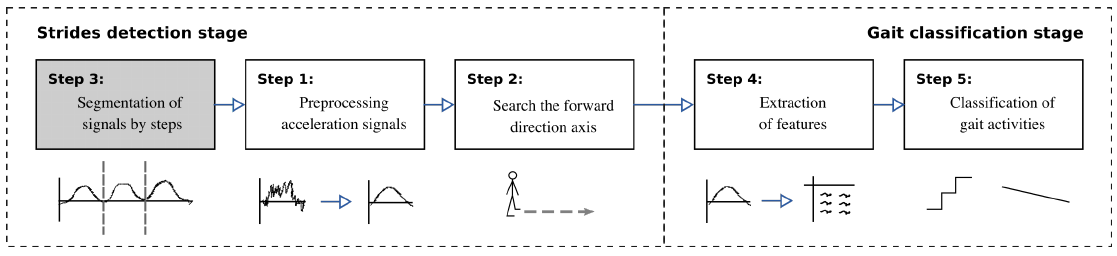
Figure 3. Adapted gait recognition method [15]. Since the data is already segmented the first step (gray) was omitted (Step 3 in